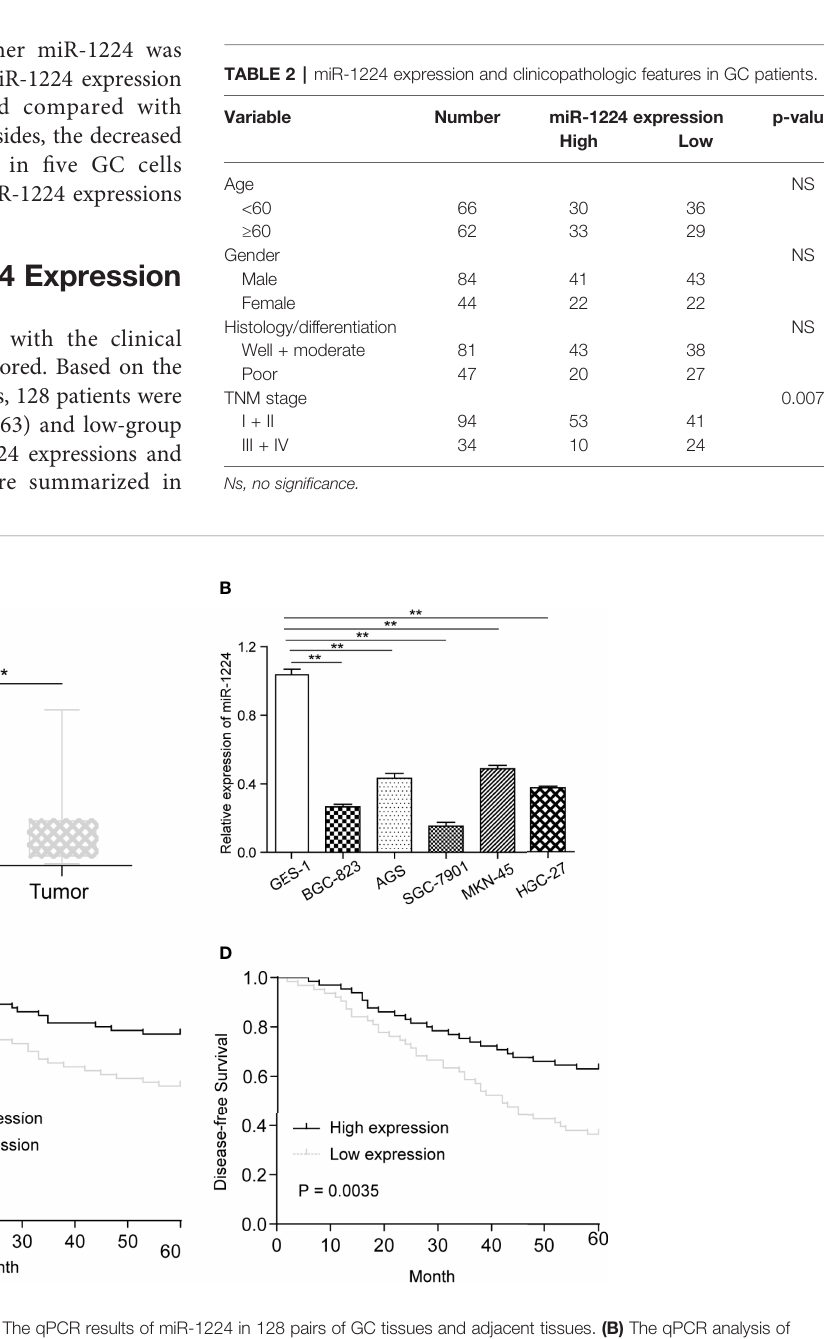
Table 2 . It can be found that low miR-1224 expression was